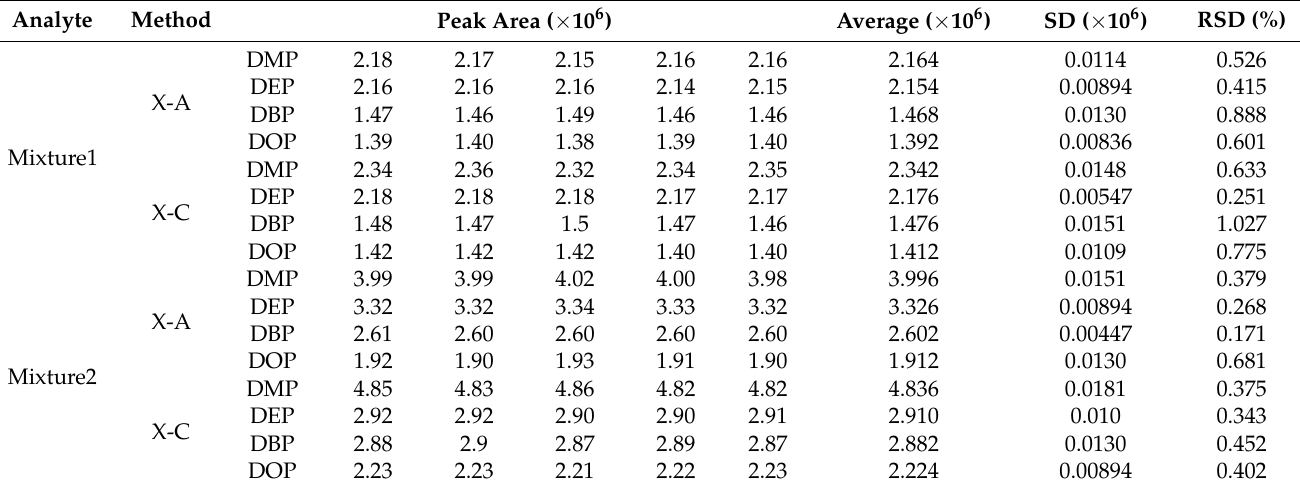
Table 7. Results of SPE of four kinds of